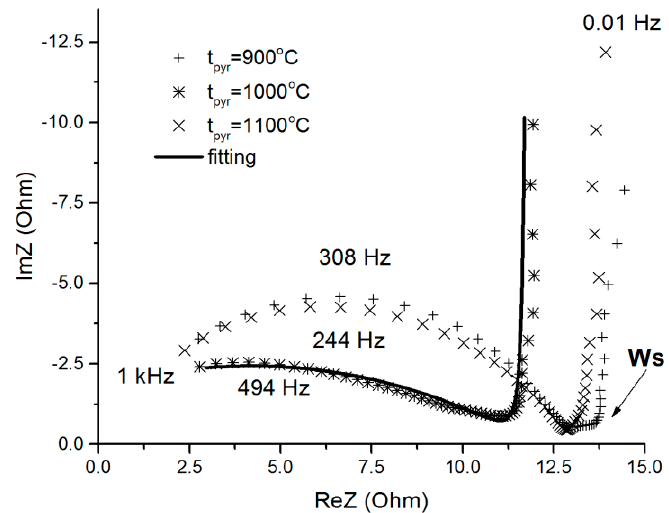
Figure 6. Spectrum of sample impedance (pyrolysis at 1000, 1100 and 900 °C) in the complex plane (hodograph). Z (cid:48) = RE (Z) is the real (active) component, Z (cid:48)(cid:48) = Im (Z) is the imaginary (reactive, (hodograph). Z’ = RE (Z) is the real (active) component, Z” = Im (Z) is the imaginary (reactive, capacitive) capacitive) component.